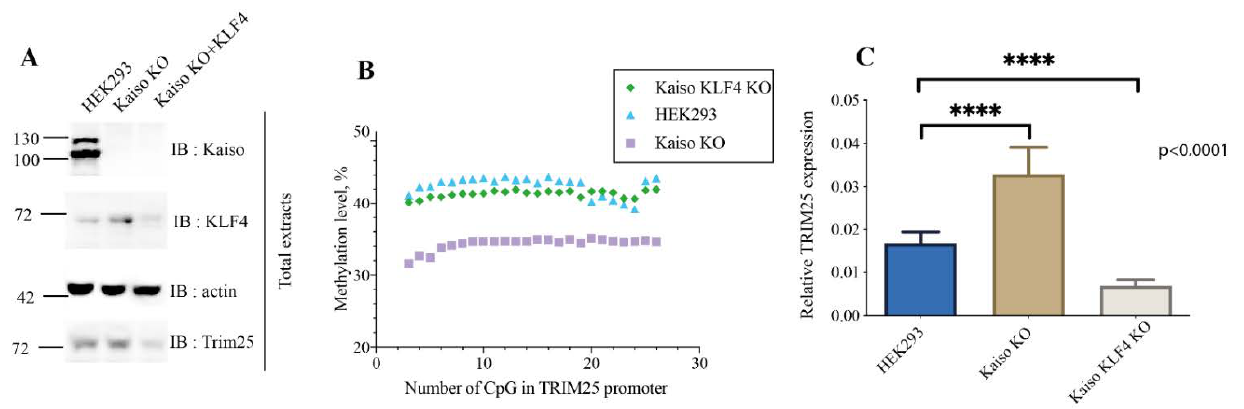
Figure 5. KLF4 is important for Kaiso-dependent regulation of TRIM25 promoter methylation. ( A ) Western blot analyses of total cell lysates from HEK293 cells, Kaiso KO, double knockout (KLF4 KO and Kaiso KO) mutant cell lines. ( B ) Analysis of promoter TRIM25 methylation by bisulfite conversion followed by NGS sequencing in HEK293, Kaiso KO and double knockout (Kaiso, KLF4). ( C ) qRT-PCR analysis with Taqman probe for TRIM25 transcription relative to GAPDH expression level ( n = 3, **** p -value < 0.0001, Student’s t